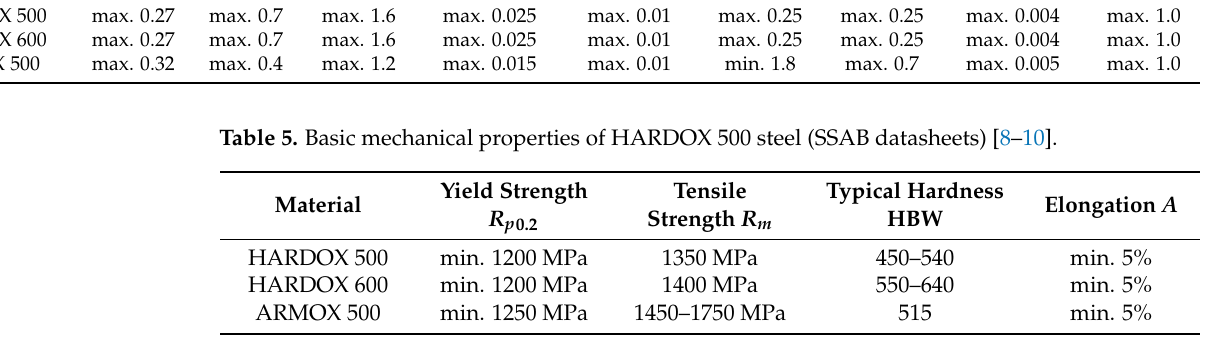
Table 4. Metal analysis of the SSAB HARDOX and ARMOX steels used. The content of the elements is provided in wt.% (SSAB datasheets) [8–10]. Material